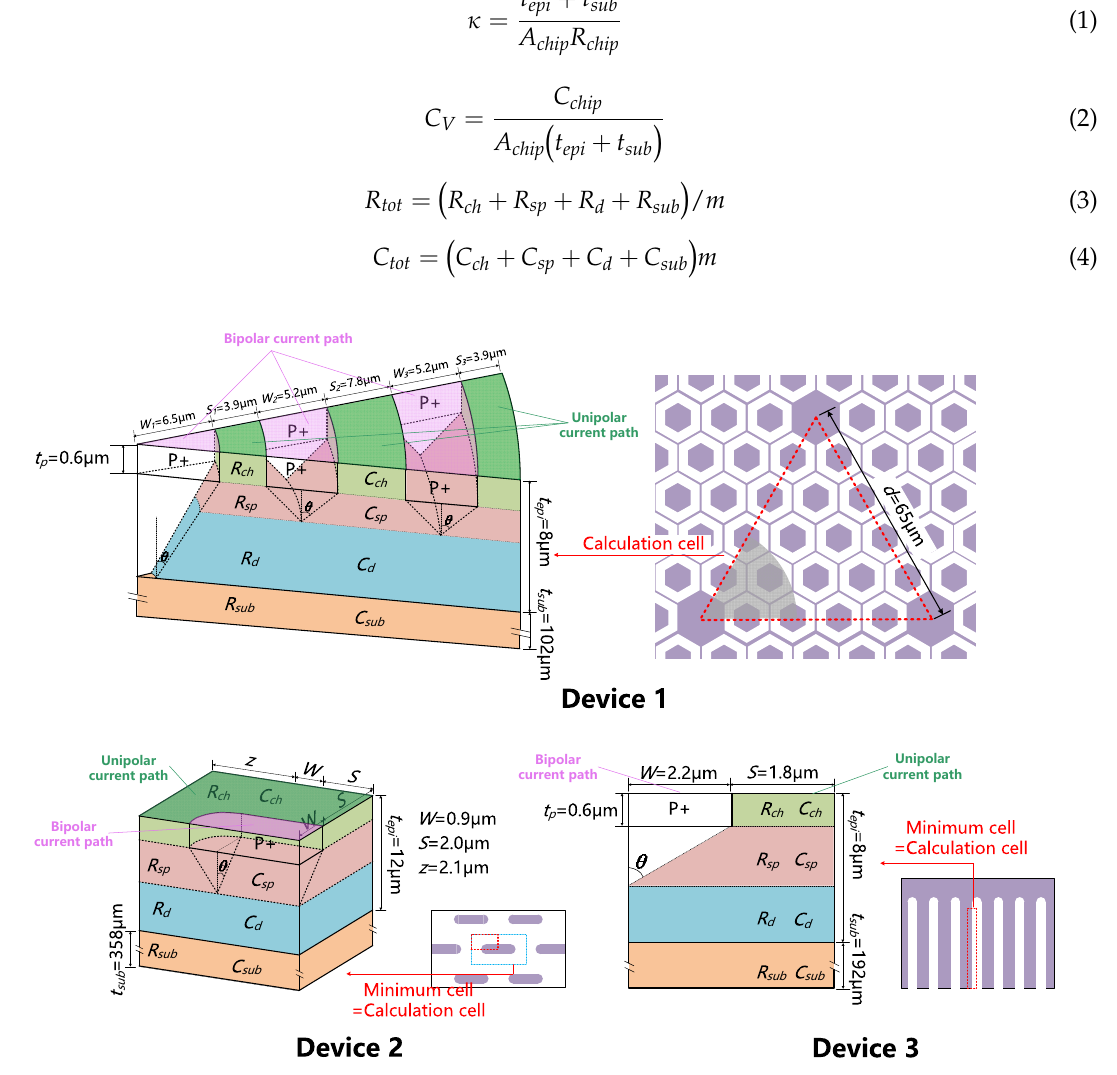
Figure 13. The current paths in a calculation cell of the three devices, which is divided into four parts (channel, spreading, drift and substrate), as labeled with different colors.